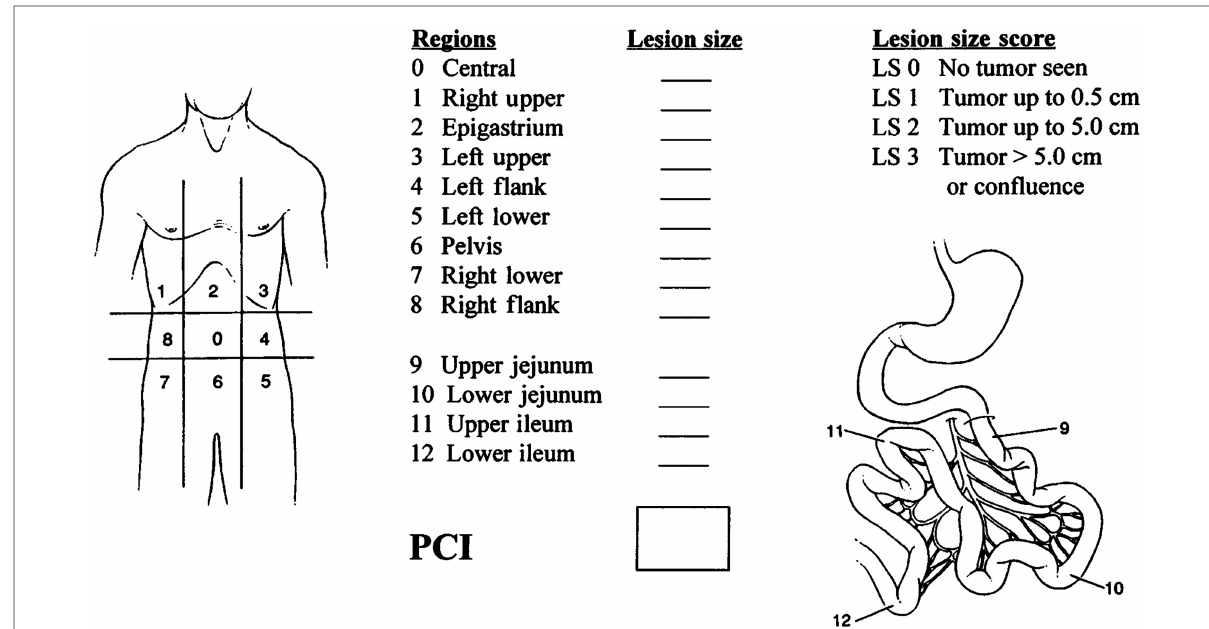
FIGURE 1 Peritoneal cancer Index (PCI) scoring system (9). Lesion size (LS) should be considered. The absence of malignant deposits is indicated by an LS-0 score: the tumor nodules less than 0.5 cm are indicated by an LS-1 score (the number of tumor nodules is not scored; only the size of the largest nodule is calculated); tumor nodules between 0.5 cm and 5.0 cm are indicated by an LS-2 score; and tumor nodules of more than 5.0 cm in either direction are indicated by LS-3 score. The con fl uence of strati fi cation of tumors also indicates a score of LS-3 in the abdominal or pelvic areas. Each of the 13 areas received an LS score. The patient ’ s peritoneal cancer index was calculated as the average lesion size score for each of the 13 abdominal-pelvic areas. The highest score was 39 or 13*3.